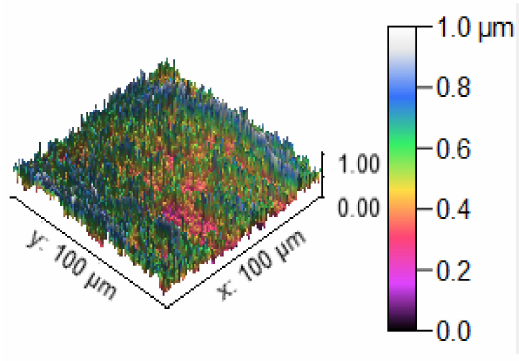
Figure 17. Three dimensional (3D) profilometric image (S-5).